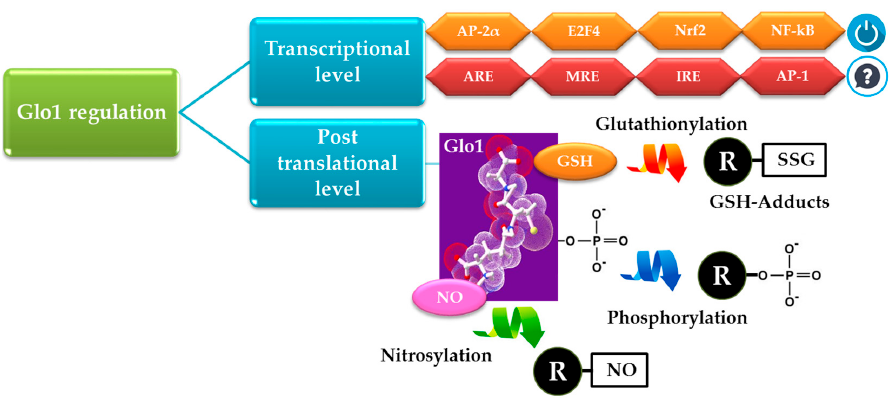
Figure 4. Mechanisms of glyoxalase 1 (Glo1) regulation. Glo1 can be regulated at transcriptional and post-translational levels. Transcriptional regulators are activator protein-2 α (AP-2 α ), early gene 2 factor isoform 4 (E2F4), nuclear factor erythroid 2-related factor 2 (Nrf2), nuclear transcription factor–kB (NF- κ B), antioxidant response (ARE), metal-response (MRE) and insulin-response (IRE) elements, and activator protein-1 (AP-1). It has been shown that AP-2 α , E2F4, Nrf2 and NF- κ B enhance (switch on symbol) the activity of Glo1 promoter, and up-regulate Glo1 expression. As to Glo1 regulation by ARE, MRE, IRE and AP-1, a clear demonstration has not been provided yet (question mark symbol). Post-translational modification can occur via glutathionylation, phosphorylation and nitrosylation. GSH: reduced glutathione, NO: nitric oxide; R: the “variable” or “R” group of proteins.